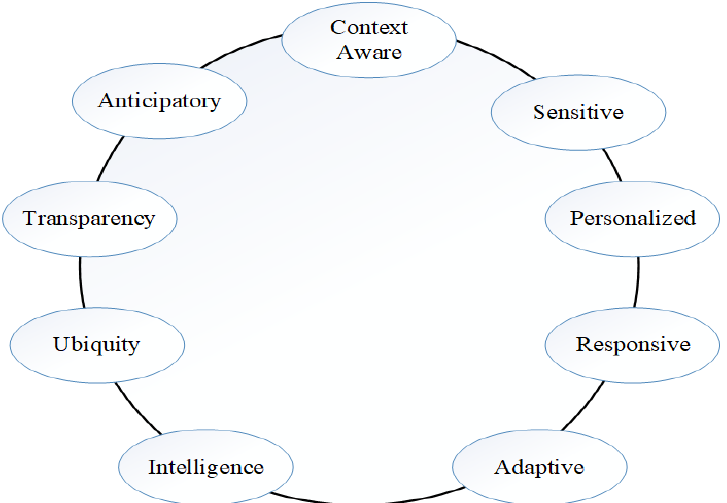
Figure 4. Characteristic of smart